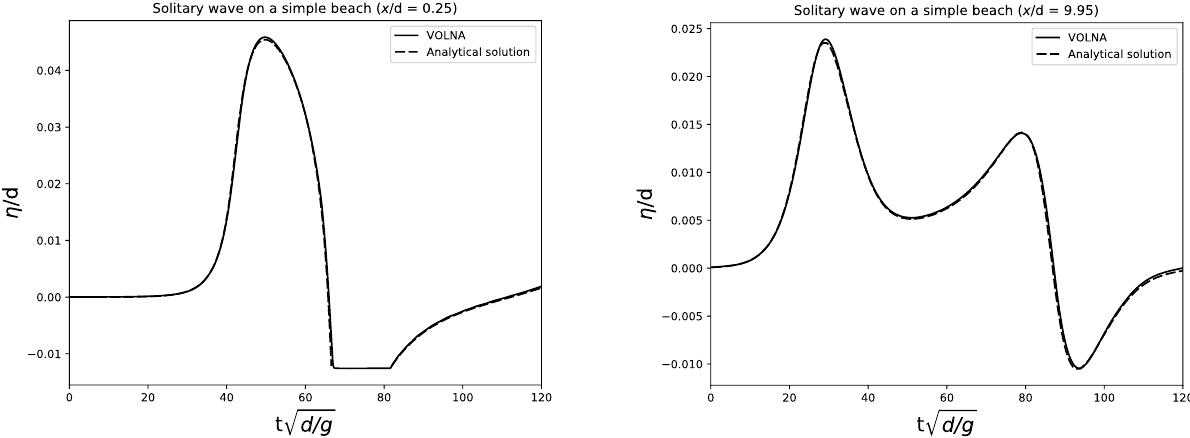
Figure 3. Solitary wave on a simple beach – comparison between VOLNA and solution at different locations: (a) x/d = 0 . 25: notice that the location becomes “dry” for t ≈ ( 67